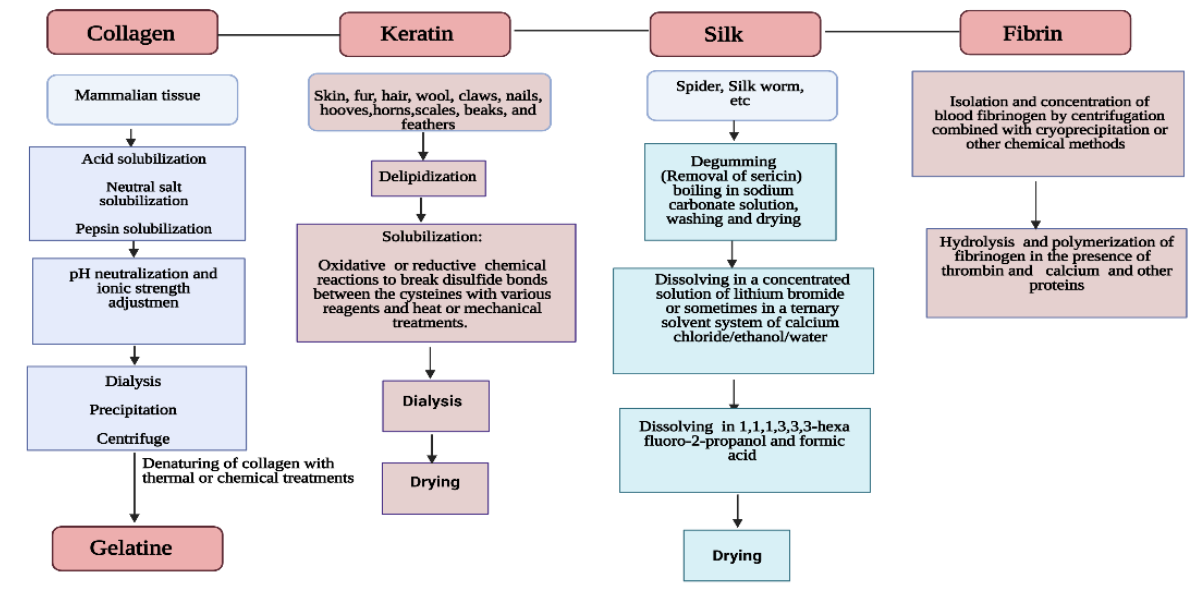
Figure 1. Sources, production and purification methods of some of the protein-based